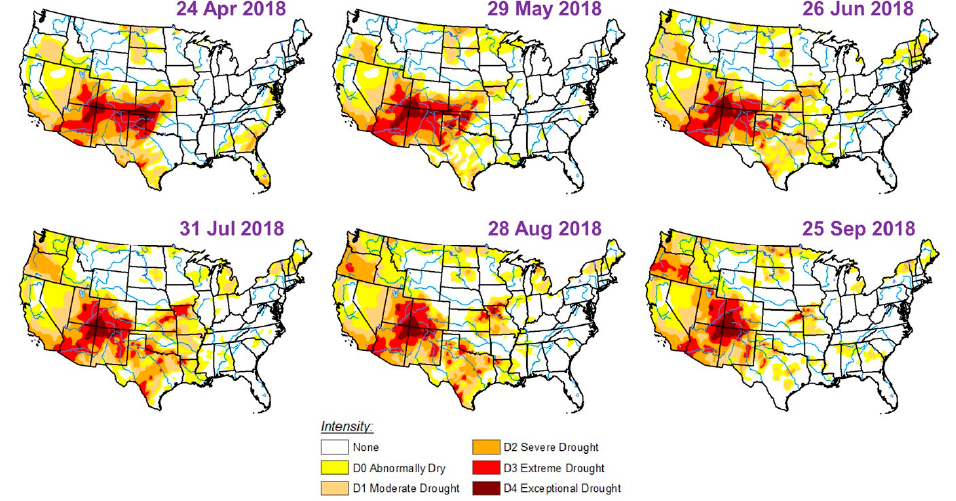
Figure 8. U.S. Drought Monitor for the 2018 warm season at the end of each month from April to